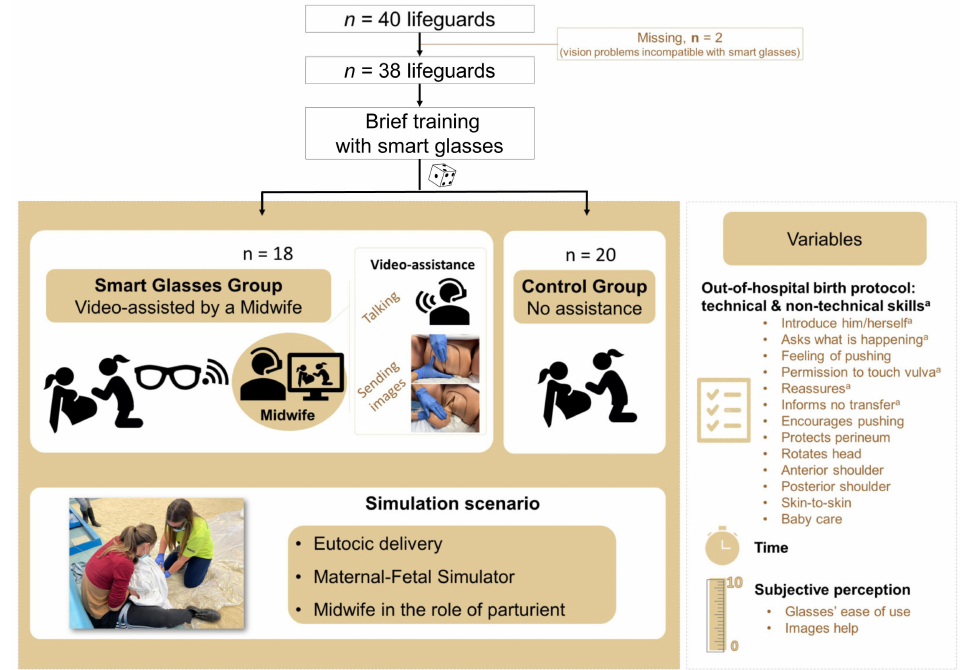
Figure 1. Flowchart design and sample of